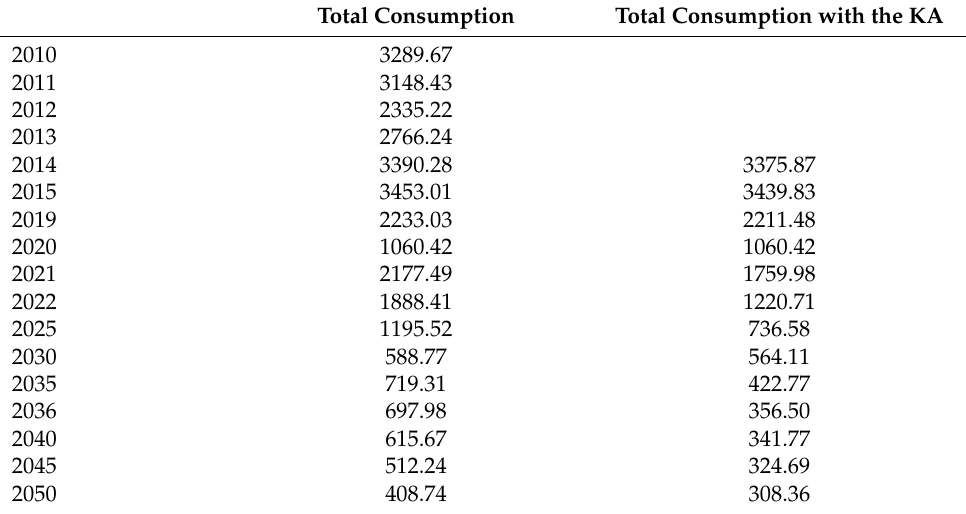
Table 2. Total F-gas consumption in years 2010–2050, with and without the KA reduction (kt CO 2 eq.).